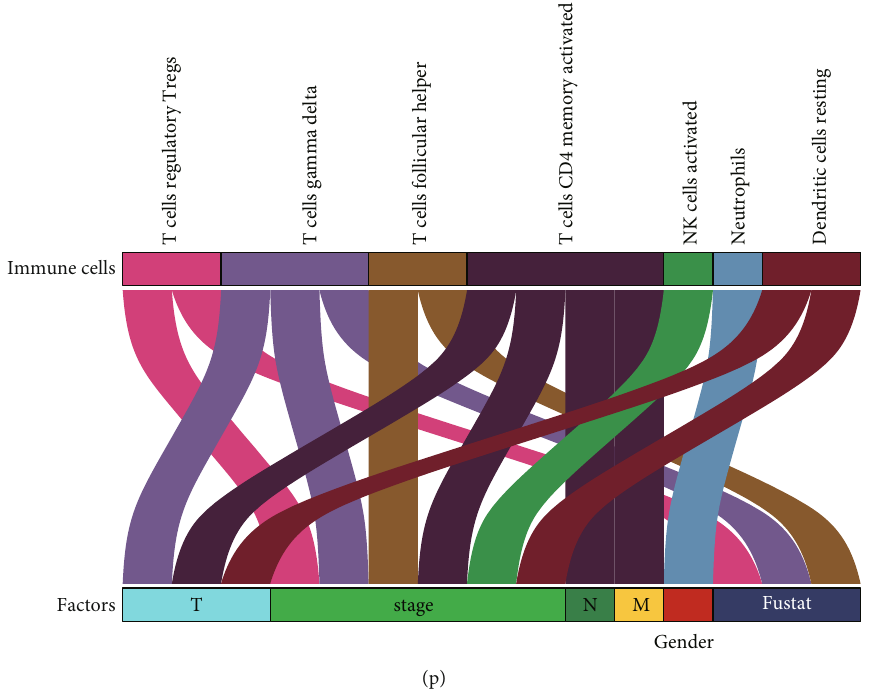
Figure 6: The signi fi cant correlation between the CRC immune microenvironment and clinical speci fi city pathological factors ( p Filter = 0 : 05 ) is shown in (a – o), and (p) illustrates the association between 7 hub-TII cells and CRC clinical pathological